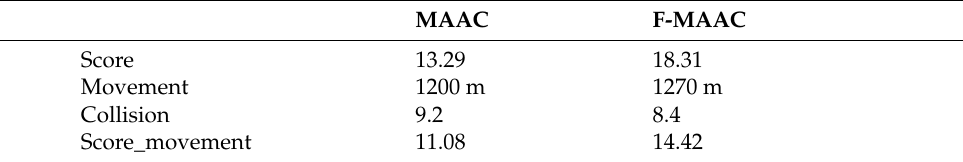
Table 7. Overall comparison of MAAC and F-MAAC